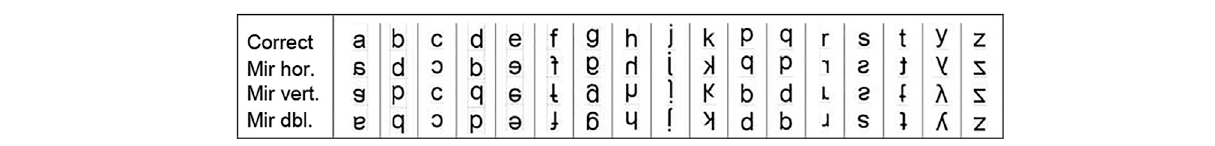
FIGURE 2 | The asymmetrical lower case letters, originally displayed in Arial 90 dots, and their different mirrors: horizontal, vertical, double (both horizontal and vertical).